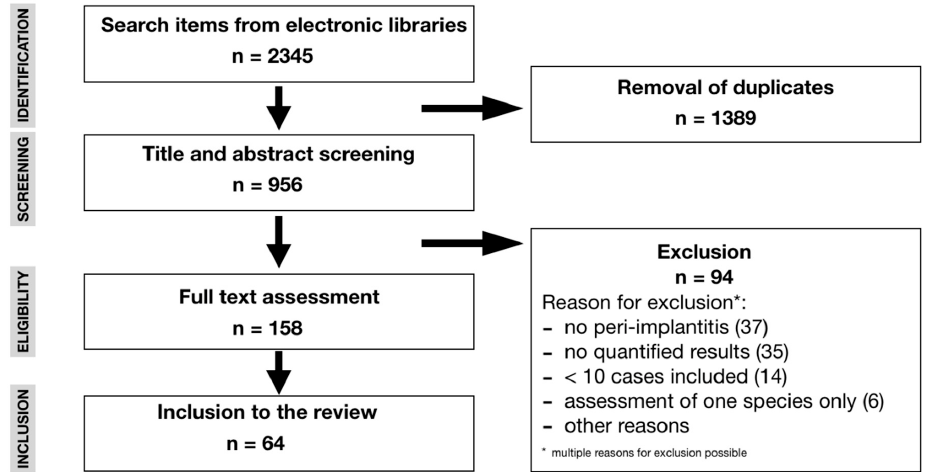
Figure 1. Search Figure 1. Search strategy.